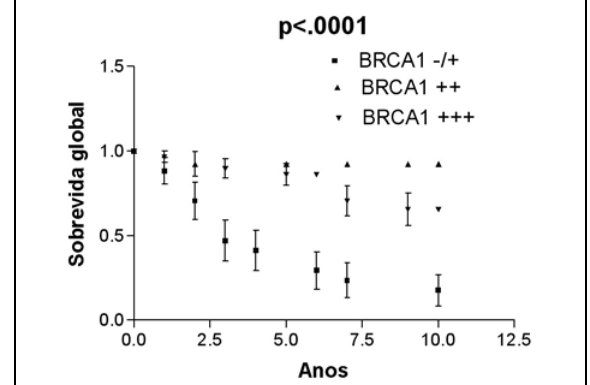
Figura 2 – Taxa de sobrevida global em relação à reportagem de expressão do